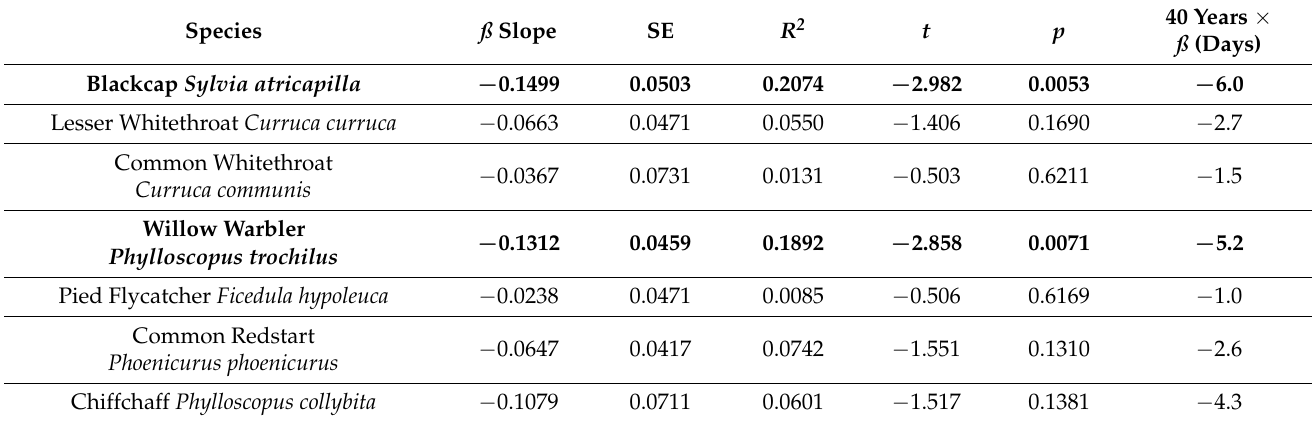
Table A3. Summary statistics for linear regressions of the Annual Anomalies (AA) of spring migration phenology of six species of long-distance migrants against the year, at Bukowo, Poland, in 1982–2021. The linear regressions are presented in Figure 6. ß slope = regression coefficient; SE = Standard Error; R 2 —determination coefficient; t, p = results of t -test, p < 0.05 marked in bold face, 40 × ß = estimated change in days of migration timing over 1982–2021, negative values reflect earlier migration.